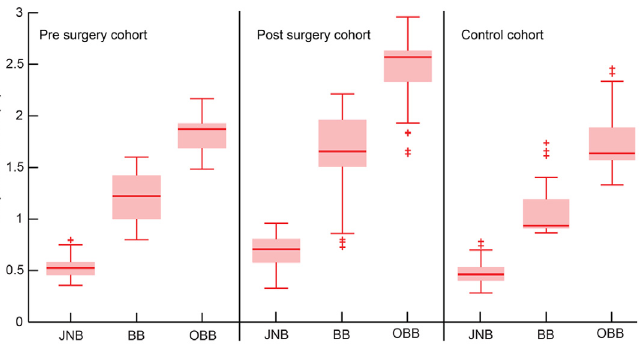
Fig 8. Box and whisker plots of the DOF obtained from the second control experiment. Data obtained from the three different DOF criteria are shown in each panel. Details of the box and whisker plot are similar to Fig